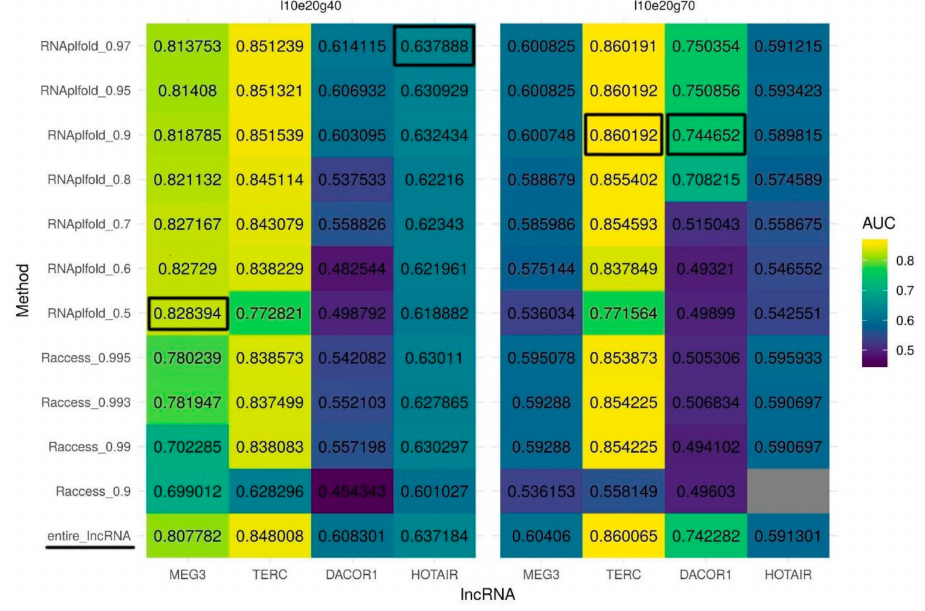
Figure 2. Quality of triplexes predictions with the two sets of parameters. (left panel) The best set of parameters for lncRNAs MEG3 and HOTAIR (l10e20g40: minimum length of 10 bp, maximum error rate of 20%, minimum G-content of 40%, Table 1); (right panel) The best set of parameters for lncRNAs TERC and DACOR1 (l10e20g70: minimum length of 10 bp, maximum error rate of 20%, minimum G-content of 70%, Table 1). Two secondary structure prediction tools were evaluated: RNAplfold and Raccess with a wide range of thresholds. The last row (entire_lncRNA) corresponds to a quality of triplexes prediction with no secondary structure being used. Prediction quality is measured by an AUC (colored scheme). Gray color represents the lack of predicted